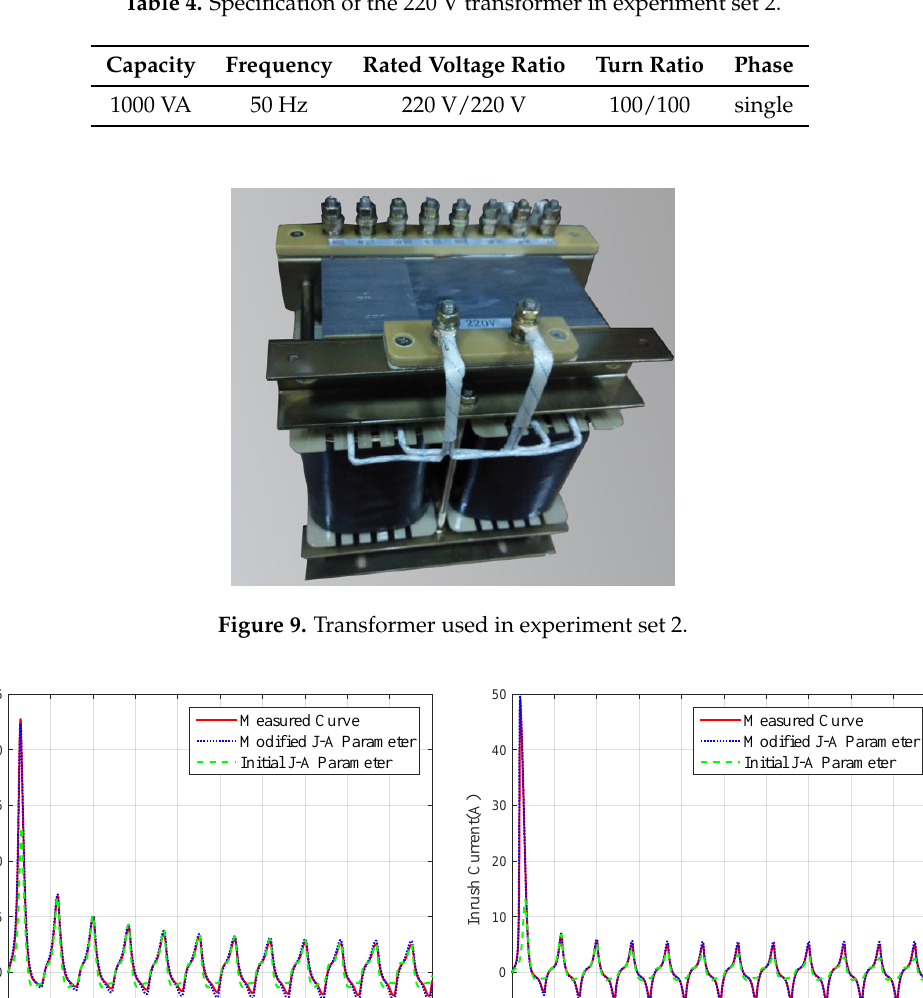
Table 4. Specification of the 220 V transformer in experiment set 2.